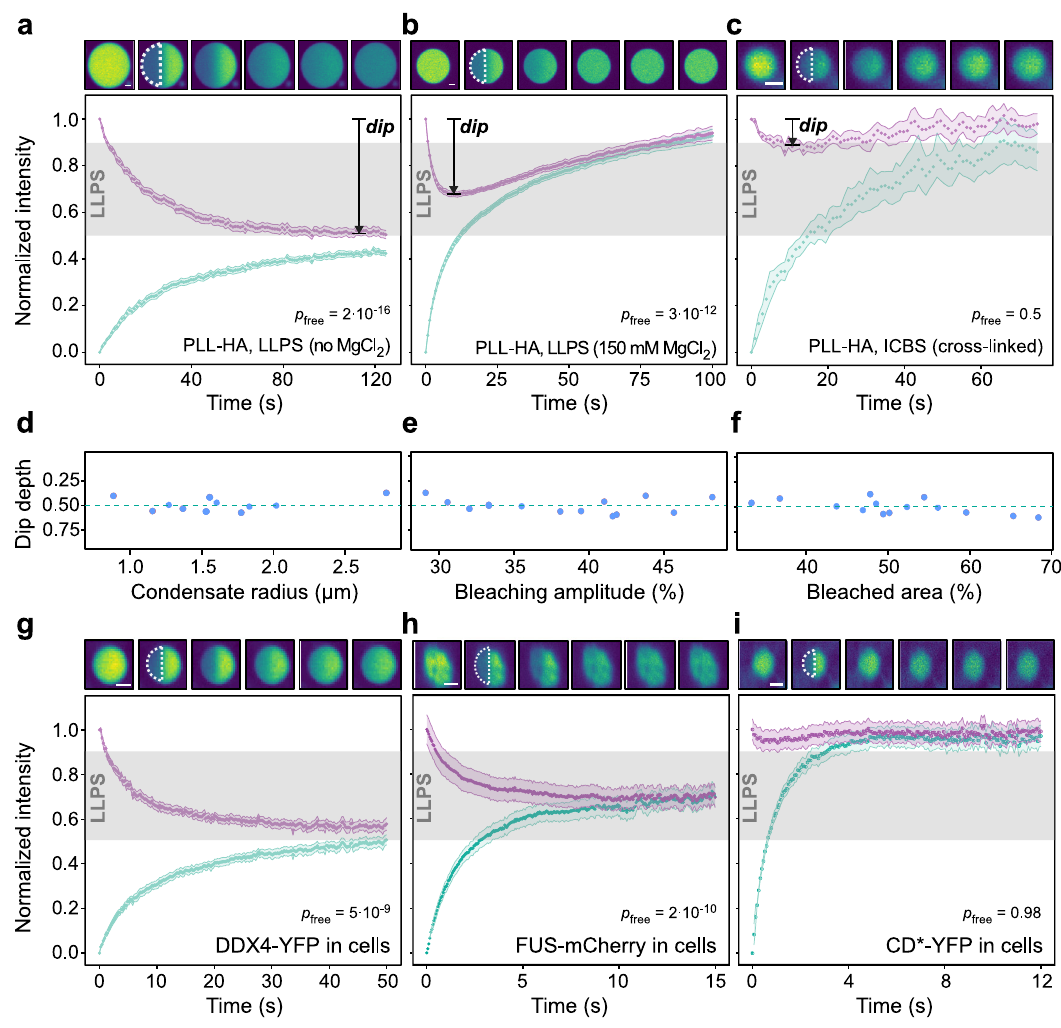
Fig. 2 | Half-FRAP differentiates condensates formed by LLPS from clusters formed by ICBS. a – c Half-FRAP curves, including the normalized intensity in the bleached half (cyan) and the non-bleached half (magenta). Gray areas in the plots indicate the range of dip depths in the non-bleached half that correspond to LLPS. Half-FRAP curves for PLL-HA coacervates without magnesium chloride ( a ), PLL-HA coacervateswith150mMmagnesiumchloride( b )andPLLundergoing ICBS( c )are shown.Toppanelsshowrepresentativesnapshotsbeforethebleachand0,515,50, and 75s after the bleach. p -values based on a one-sided Student ’ s t -test against the dip depths obtained for free diffusion are indicated. d Dip depths measured for